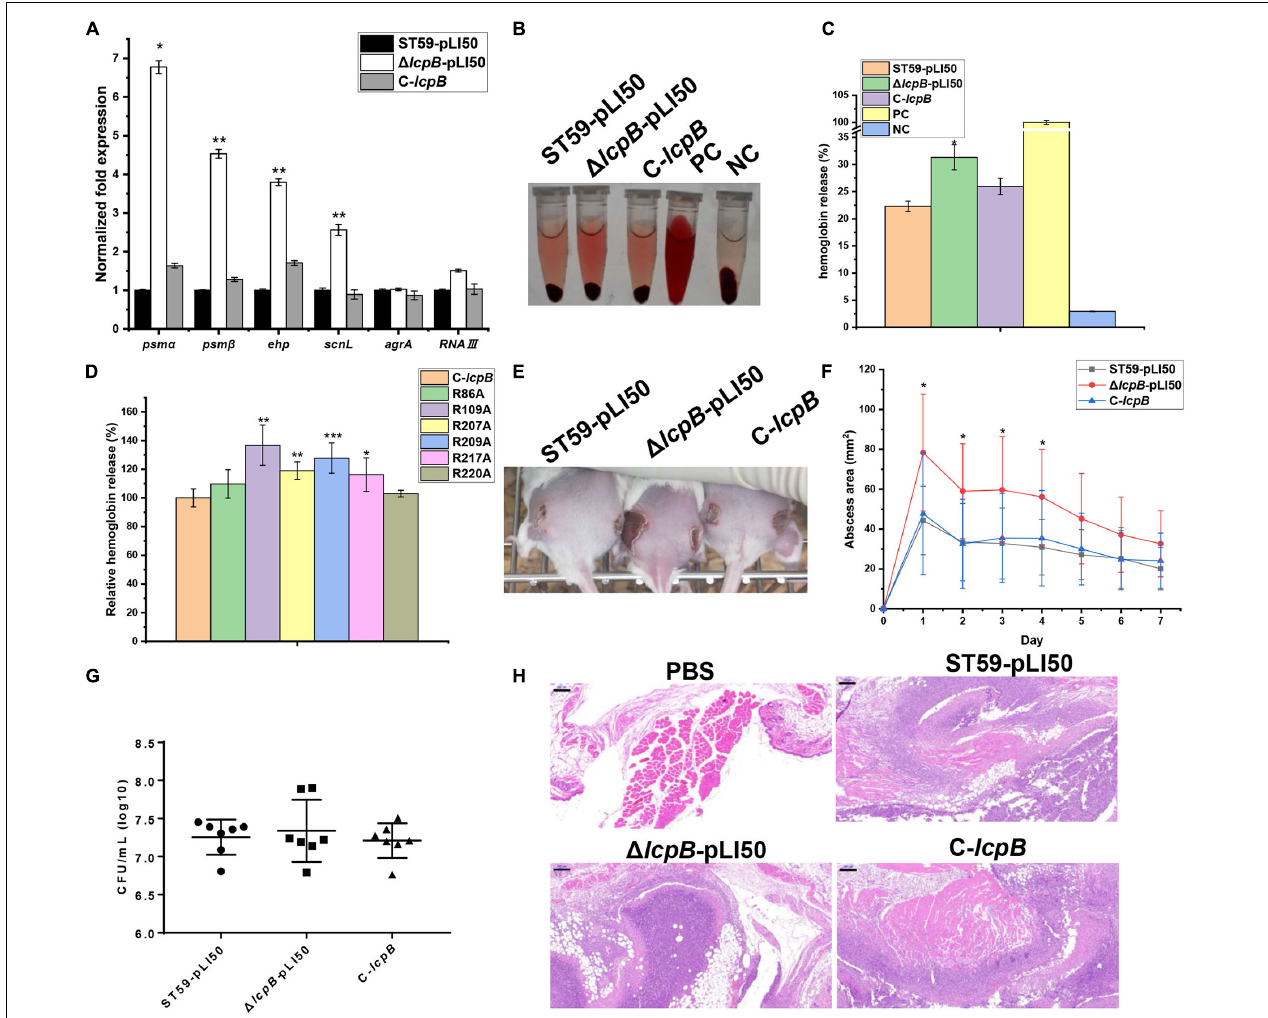
FIGURE 4 | Contribution of LcpB to virulence. (A) The transcriptional levels of genes related to virulence in the wild-type, lcpB mutant, and complemented strains were examined through RT-qPCR. The means and standard deviations were then calculated and data is presented as the mean ± standard deviation. * p < 0.05; ** p < 0.01. (B) Hemolytic activity in the wild-type, lcpB mutant, and complemented strains was determined by incubating samples with 10% sheep red blood cells for 1 h. PBS and ddH 2 O were used as the negative control and the positive control, respectively. (C) Hemolytic activity in the wild-type, lcpB mutant, and complemented strains was determined by measuring the absorption of supernatants at 543 nm. Data is presented as the mean ± standard deviation. Two-tailed Student’s t -test is used for the comparison of statistical significance. * p < 0.05. (D) Hemolytic activity in the lcpB complemented and single mutated strains was determined by measuring the absorption of supernatants at 543 nm for 1 h. Data is presented as the mean ± standard deviation. Two-tailed Student’s t -test is used for the comparison of statistical significance. * p < 0.05; ** p < 0.01; *** p < 0.001. PBS and ddH 2 O were used as the negative control and the positive control, respectively. (E–H) LcpB contributes to the virulence of S. aureus in a mouse model of subcutaneous abscess. The mice were treated with 50 µ L of PBS containing 2.5 × 10 8 CFU of the wild-type, lcpB mutant, and complemented strains, or PBS alone as the control. The treatment was administered in both flanks of the back by subcutaneous injection. (E,F) ( n = 6–8) The abscess area was measured daily using a caliper (F) . The photographic images (E) of representative abscesses in mice 7 days after infection. The error bars indicate the standard errors of the means, obtained from three biological replicates. Data is presented as the mean ± standard deviation. Two-tailed Student’s t -test is used for the comparison of statistical significance. * p < 0.05; ** p < 0.01; *** p < 0.001. (F) CFU recovered from each abscess harvested 7 days after infection were determined through serial dilution and plating on LB agar plates. (H) Representative images of histological analysis (H&E stain). The scale bar is 200 µ